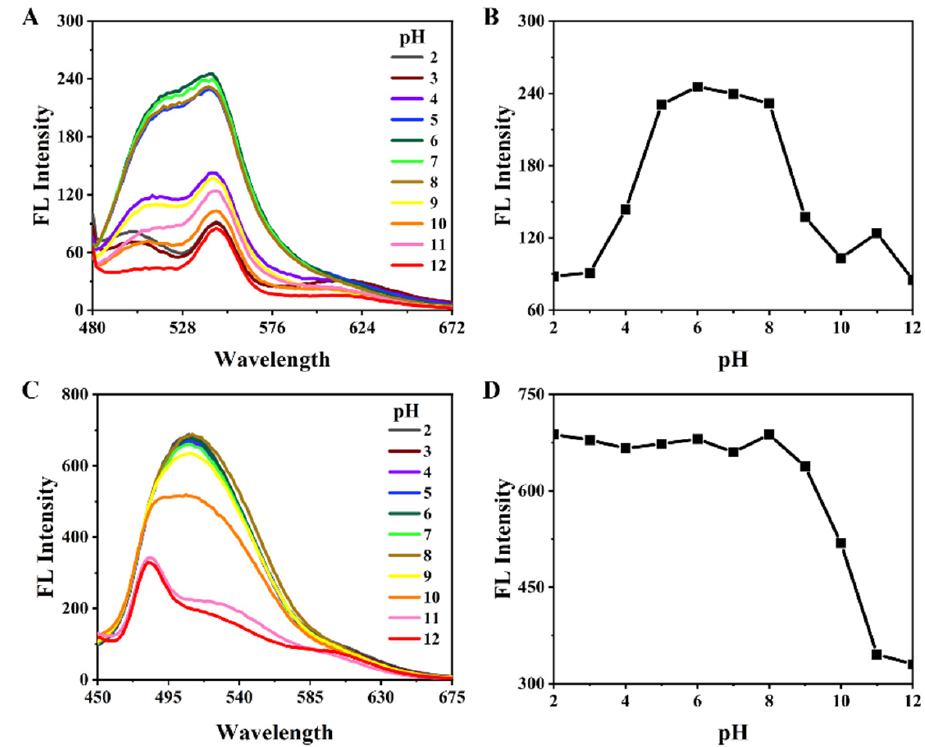
Figure 5. ( A ) Fluorescence spectra and ( B ) change in fluorescence intensity of BNEA in 99% aqueous solution (V H2O :V DMSO = 99:1) at different pH. ( C ) Fluorescence spectra and ( D ) change in fluorescence intensity of BNEA in 99% methanol solution (V Methanol :V DMSO = 99:1) at different pH ( λ ex = 450 nm, [BNEA] = 10 μ M).